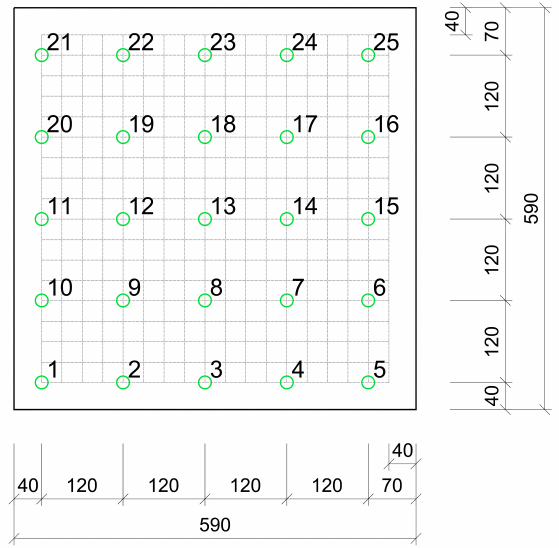
Figure 1. Spot measurement